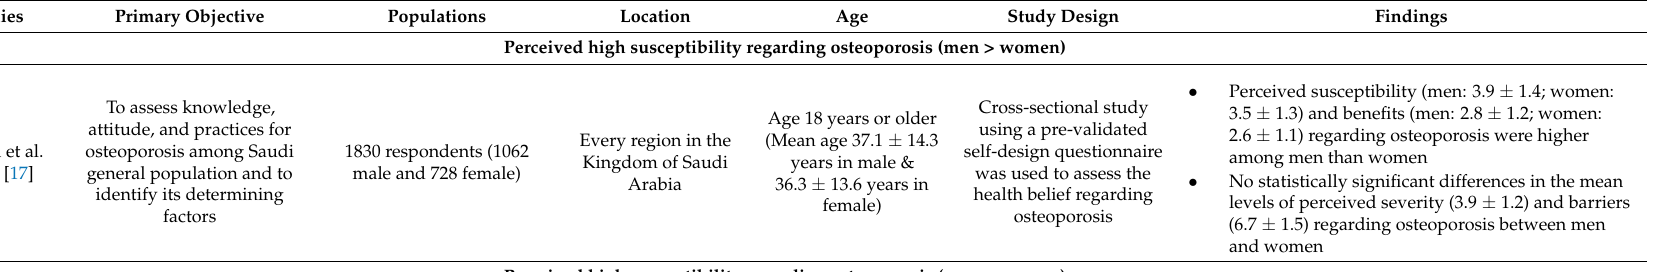
Table 2. Beliefs regarding osteoporosis among adolescents and young